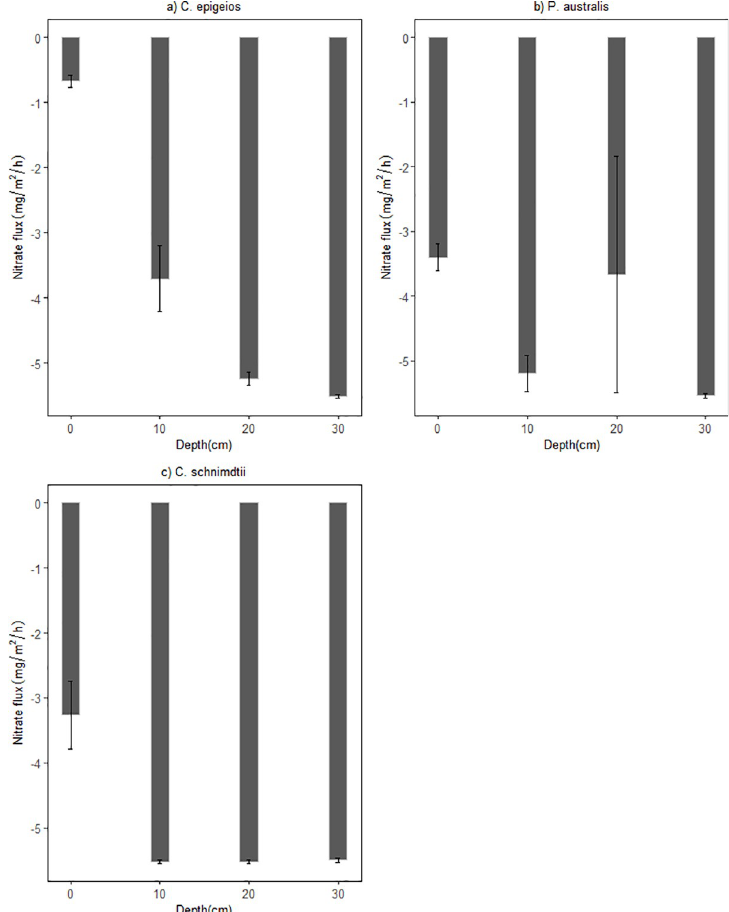
Fig 5. Hourly fluxes of surface water NO (cid:0) at different soil depths in laboratory setup incubated for 30 days. (a) 3 Soil from site dominated by C . epigeios , (b) soil from site dominated by P . australis , (c) soil from site dominated by C . schnimdtii . Error bars represent standard error of the